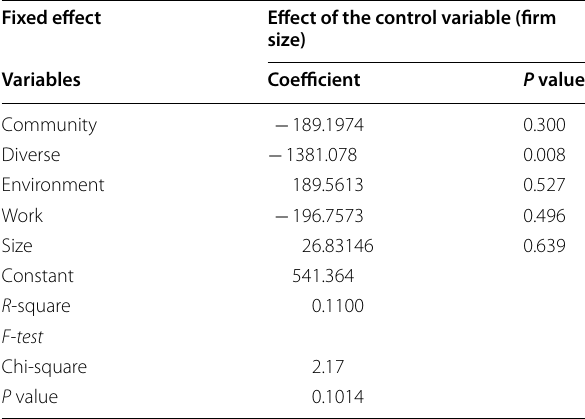
The result is evaluated based on a 95% level of significance